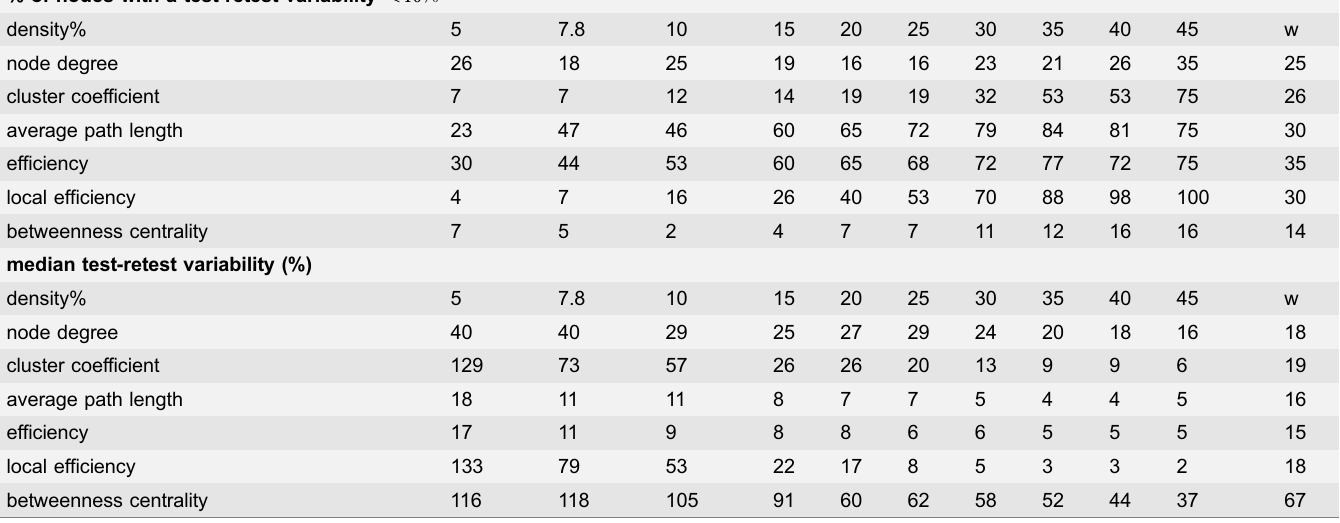
Table 4. Between independent groups: the test-retest variability of local graph measures across densities. % of nodes with a test-retest variability v 10